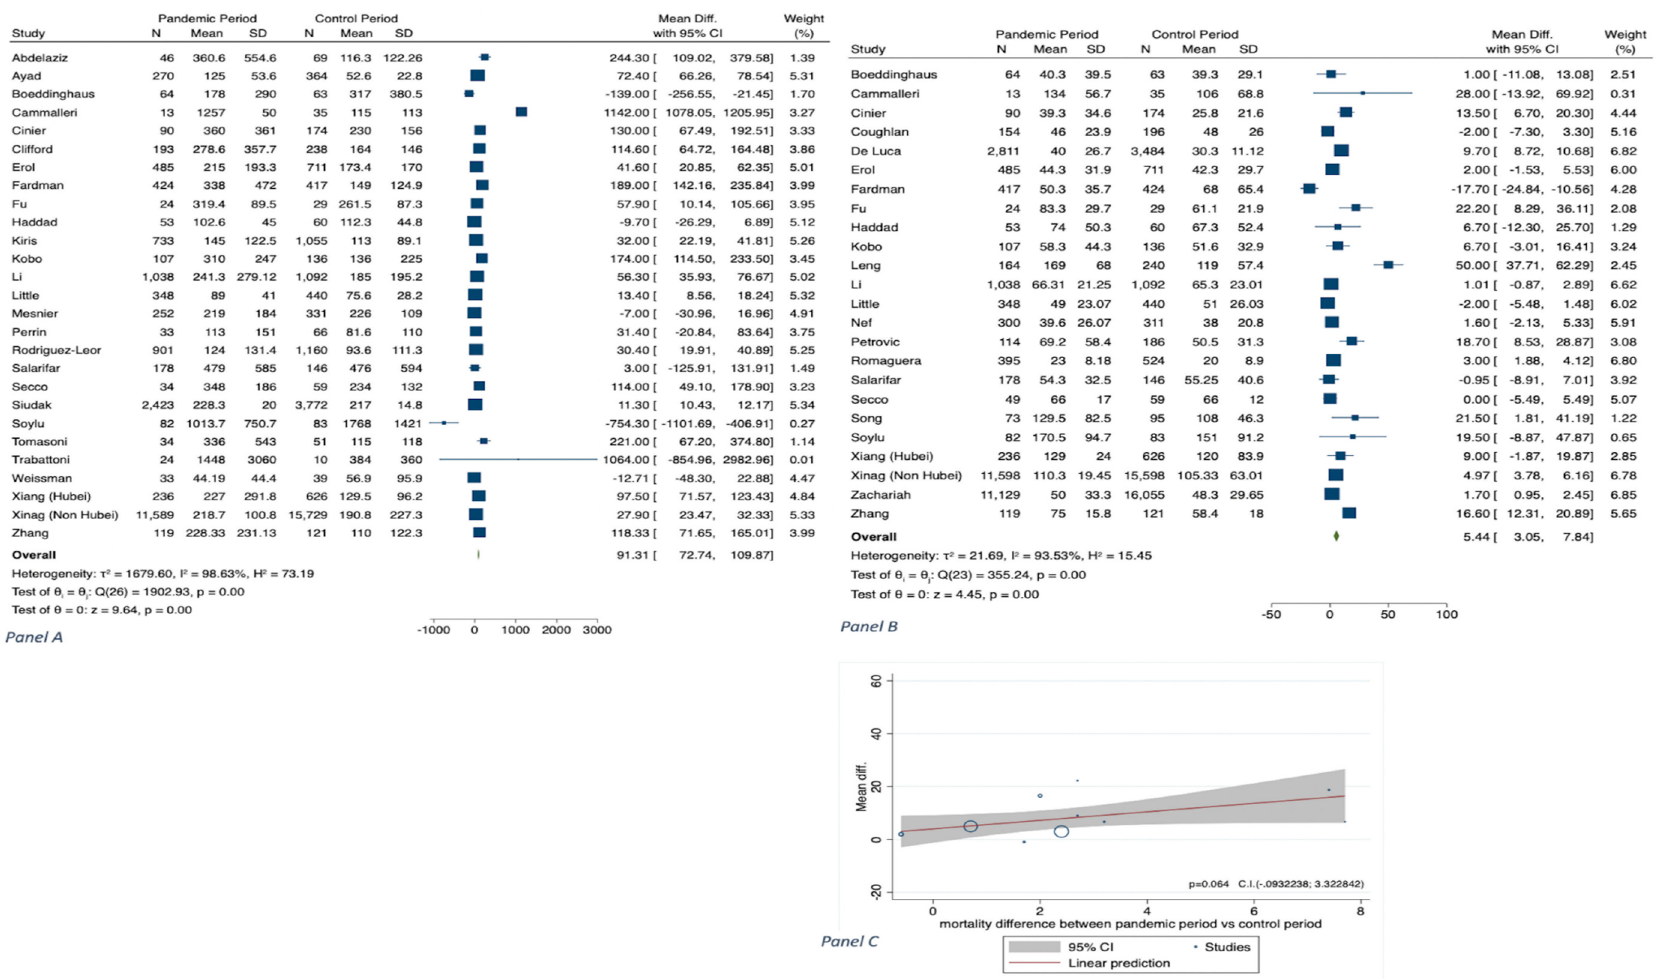
Figure 4. Panel ( A ): MD in time (minutes) from symptom onset to first medical contact. Panel ( B ): MD in door-to-balloon time (minutes). Panel ( C ): Meta-regression analysis: relationship between differences in door-to-balloon time and mortality during COVID-19 pandemic in 2020 vs. corresponding control period.